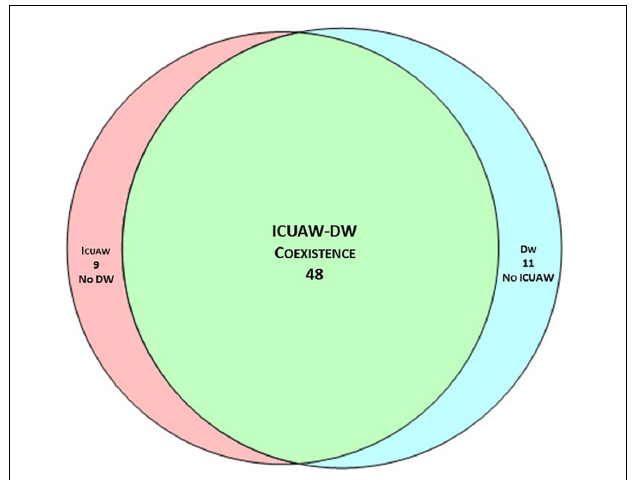
FIGURE 2 | Venn diagram of ICUAW and DW coexistence. The coexistence of the two conditions occurred in 48 patients (65%); there was no association between ICUAW and DW ( χ 2 = 1.06, p = 0.304).